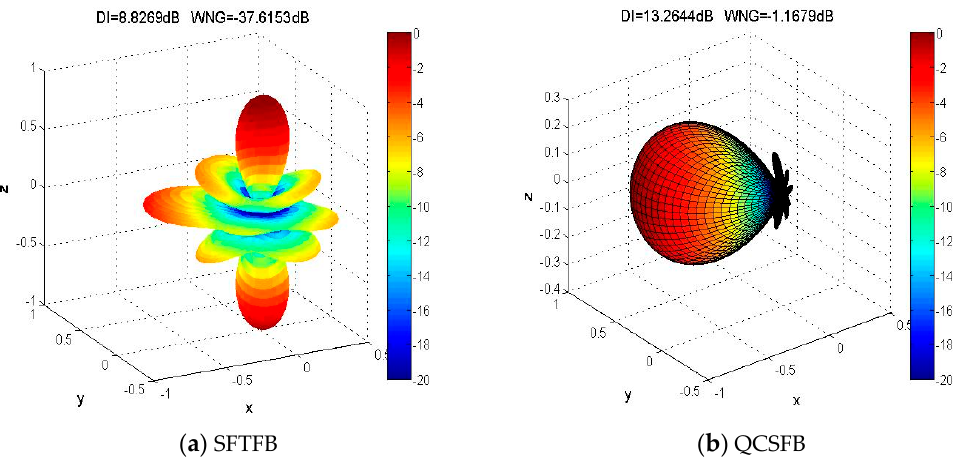
Figure 2. Three-dimensional beam patterns for ( a ) the spherical Fourier transform focused beamforming (SFTFB) method and ( b ) the quadratic constraint spherical focused beamforming (QCSFB) method.